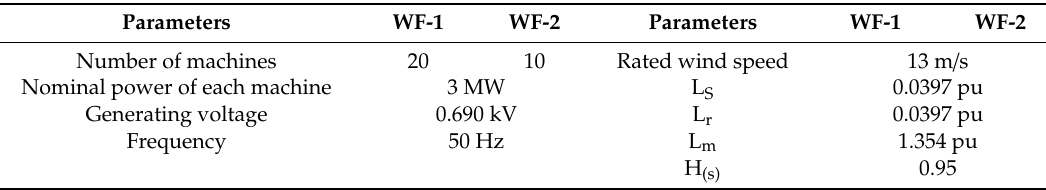
Table A1. WTG parameters used in IEEE-8 bus